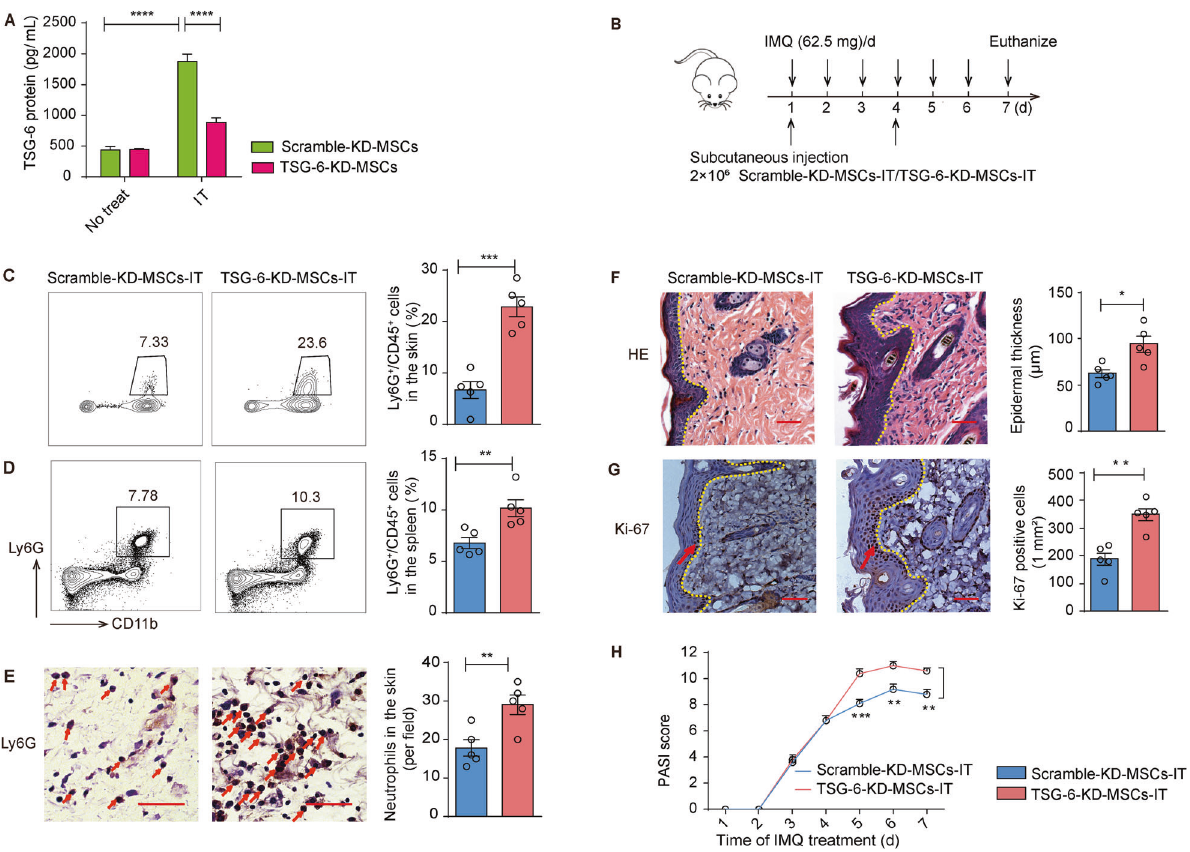
Fig. 4 MSCs-IT required TSG-6 to ameliorate psoriatic in fl ammation. The psoriatic mice were randomly injected subcutaneously with 2 × 10 6 scramble-KD-MSCs-IT and TSG-6-KD-MSCs-IT suspended in 150 µL PBS on days 1 and 4 ( n = 5 mice for each group). A The concentration of TSG-6 secreted by scramble-KD-MSCs and TSG-6-KD-MSCs with or without cytokine pretreatment for 48 h. B The experimental scheme. C , D TSG-6-KD-MSCs-IT impaired the inhibition of neutrophil in fi ltration; enumeration of neutrophil frequency in skin and spleen. E The Ly6G immunostaining of the skin in both groups; enumeration of Ly6G positive cells. F H&E staining of mice in the indicated groups; measurement of epidermal thickness. G The Ki-67 immunostaining of the skin in both groups. H The PASI scores of psoriatic mice in the indicated groups at all time points. Scale bars: 50 µm. Data were shown as means ± SEM, * p < 0.05, ** p < 0.01, *** p < 0.001, **** p <